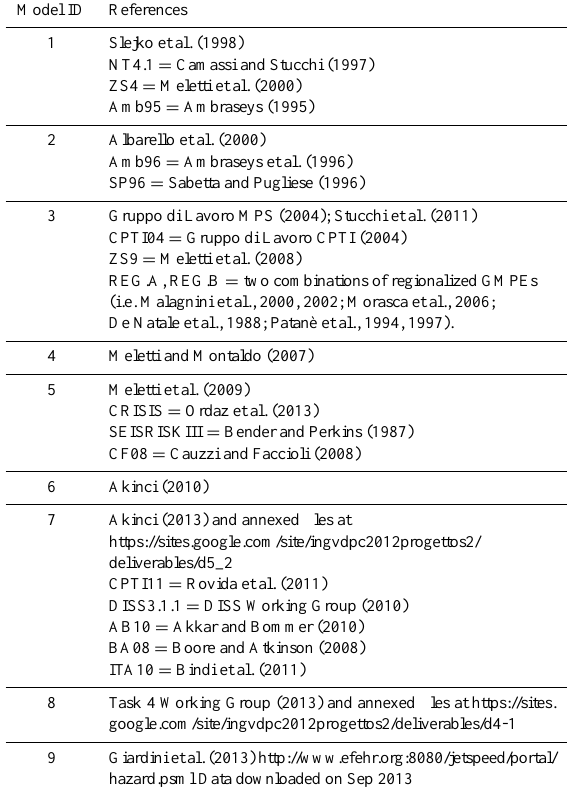
Table 2. List of references for the selected PSHA models.